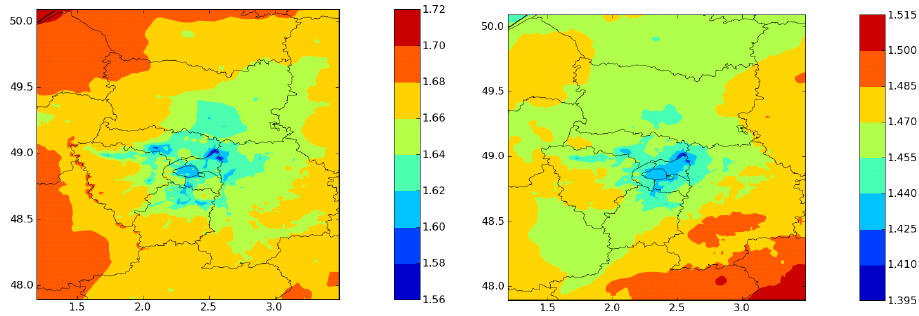
Fig. 10. Modeled OM/OC ratios with “H 2 O-Ref” (left) and “H 2 O-Mech” (right).